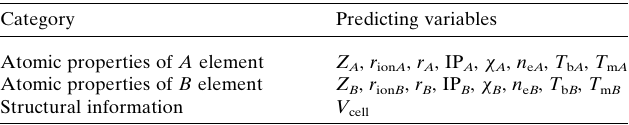
Table 1 The designed predicting variables describing the intrinsic properties of the constituent elements and the structural properties of the materials in the E form prediction problem. The A and B elements comprise the AB materials with a binary cubic structure identical to that of the Fm 3 m symmetry group.